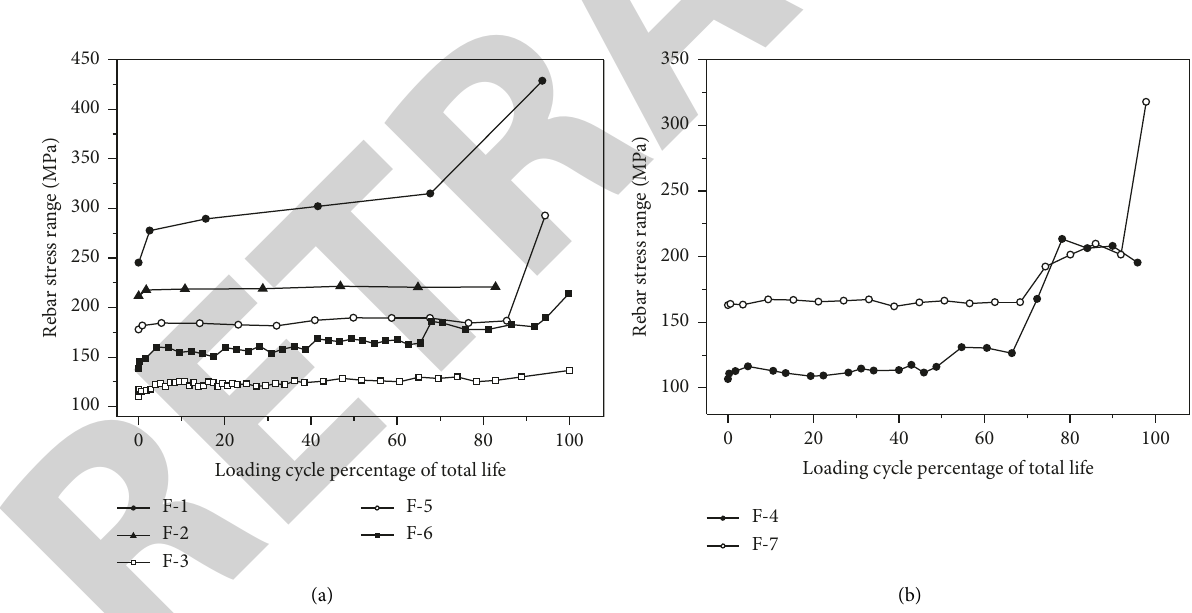
Figure 10: Overall evolution law of longitudinal rebar stress ranges. (a) Relationship between rebar stress ranges and loading cycles for F- 1 ∼ F-3, F-5, and F-6 girders. (b) Relationship between rebar stress ranges and loading cycles for F-4 and F-7 girders.